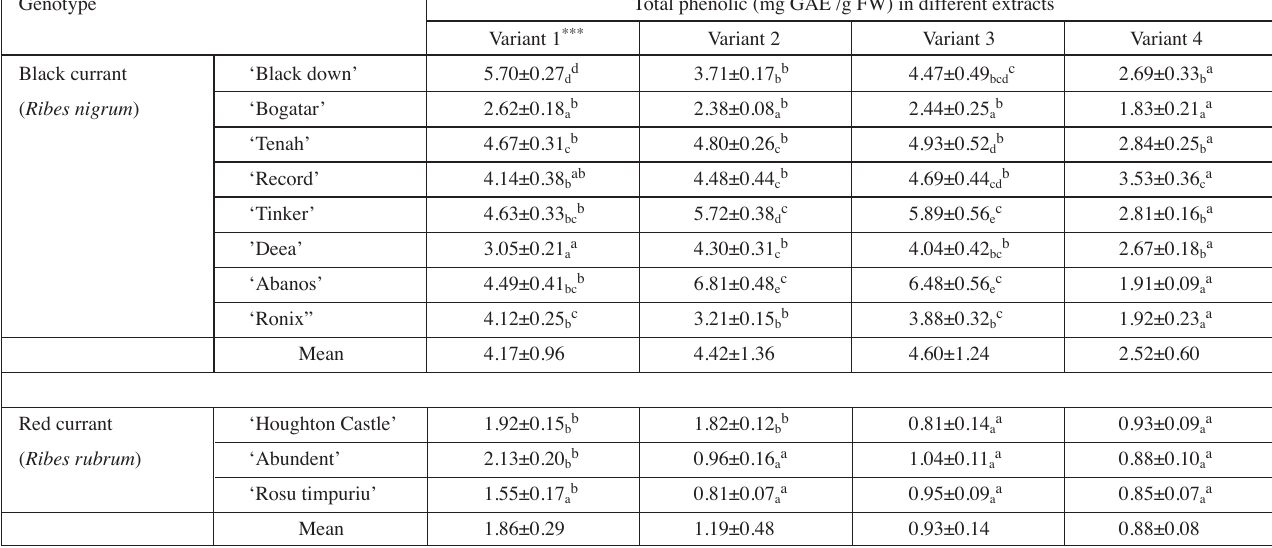
Tab. 1: Total phenolics * content of fruits in various cultivars of black and red currant